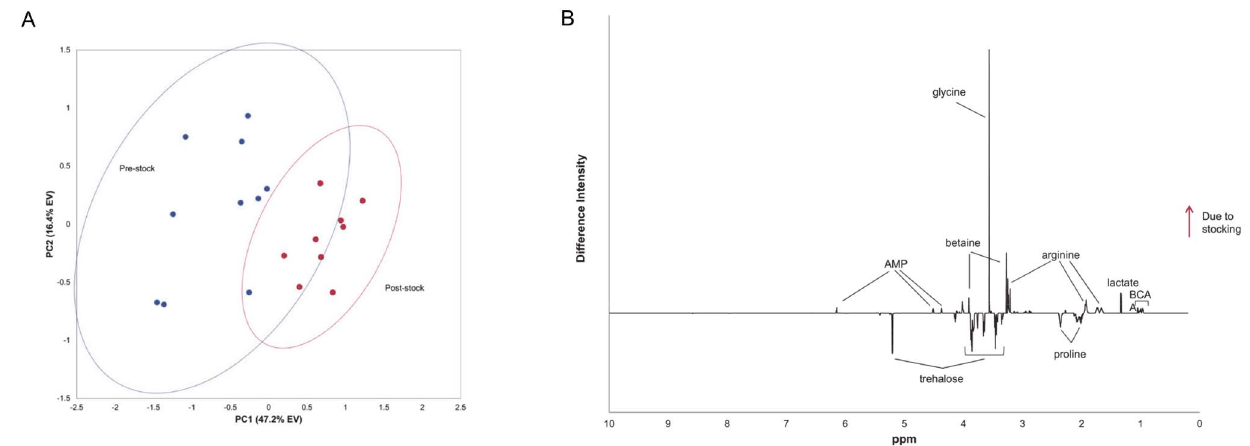
Figure 5. Stress of stocking. (A) Raceway stocking stress PCA scores plot of muscle tissue. Sampling from one day pre-stock (ND 63) and one day Post-stock (GD -7). Ellipses represent 95% confidence intervals. (B) SDS of metabolites changing in response to the stress of stocking from the nursery to the raceway. Metabolites increasing as a result of the stocking are positive and metabolites decreasing are negative.